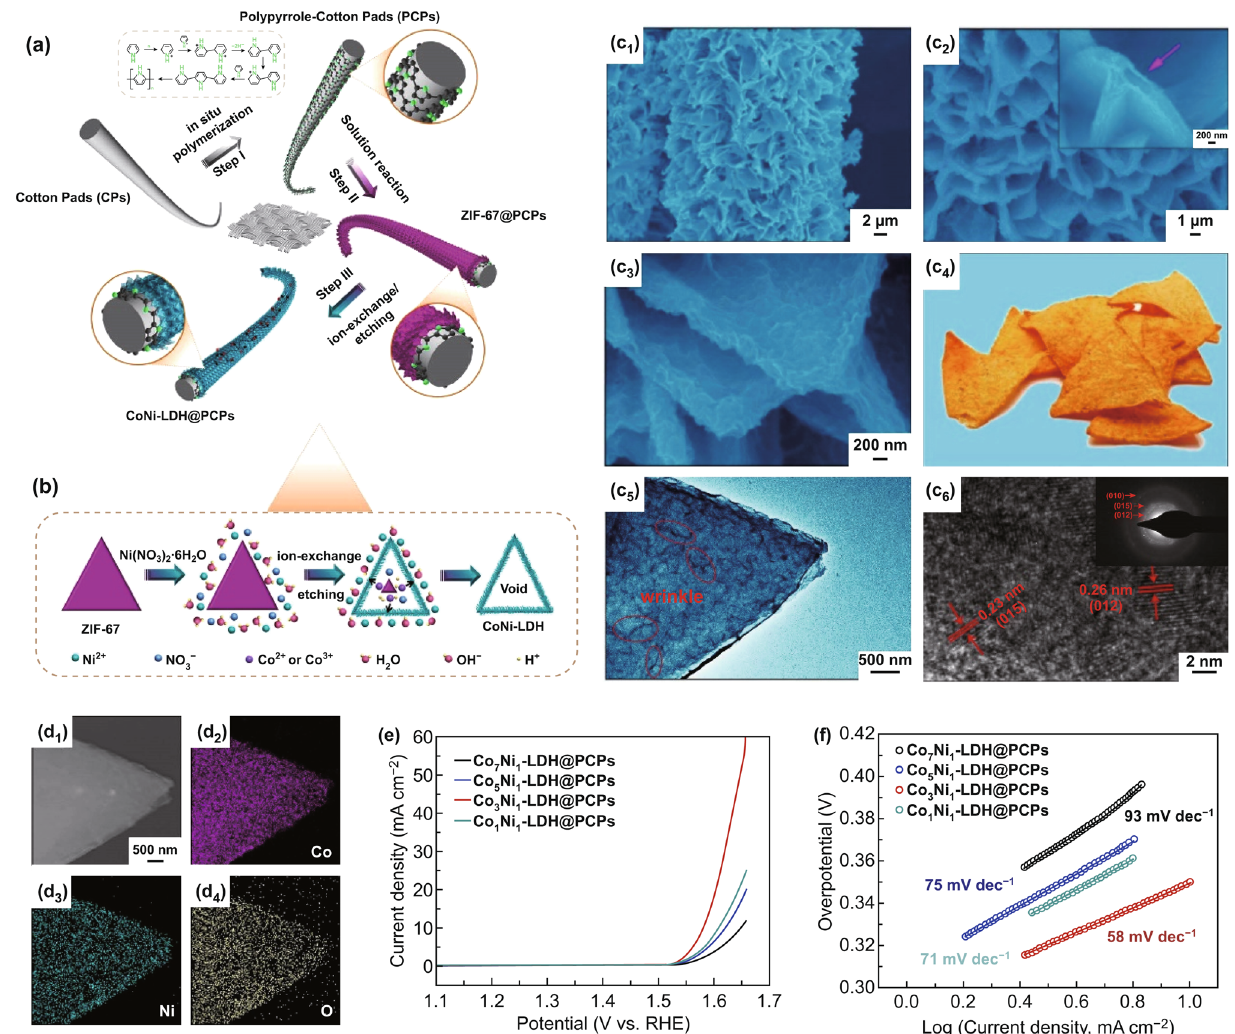
Fig. 15 a Schematic diagram of the preparation process of CoNi‑LDH@PCPs. b Formation mechanism of hollow CoNi‑LDH arrays. c SEM images (1–3) and HRTEM images (5–6) of CoNi‑LDH@PCPs, and photograph (4) of triangle biscuits. d STEM image (1) and mapping images of CoNi‑LDH arrays. e LSV curves of the different CoNi‑LDH@PCPs catalysts at 1 mV s −1 in 1 M KOH. f Tafel plots of the different CoNi‑ LDH@PCPs catalysts. Reproduced with permission of Ref. [124]. Copyright 2019 American Chemical